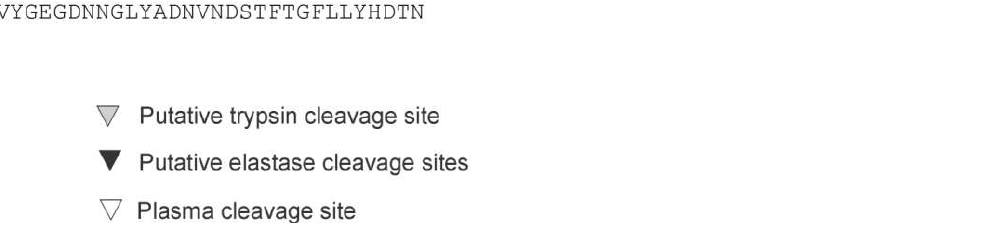
Figure 3. The relative positions of the trypsin, elastase and plasma cleavage sites are indicated on the amino acid sequence of mouse adiponectin. Trypsin and elastase sites were identified from the literature [12,13], while the site cleaved by incubation with plasma was determined with Mass spectrometry and Edman degradation sequencing procedures as described in